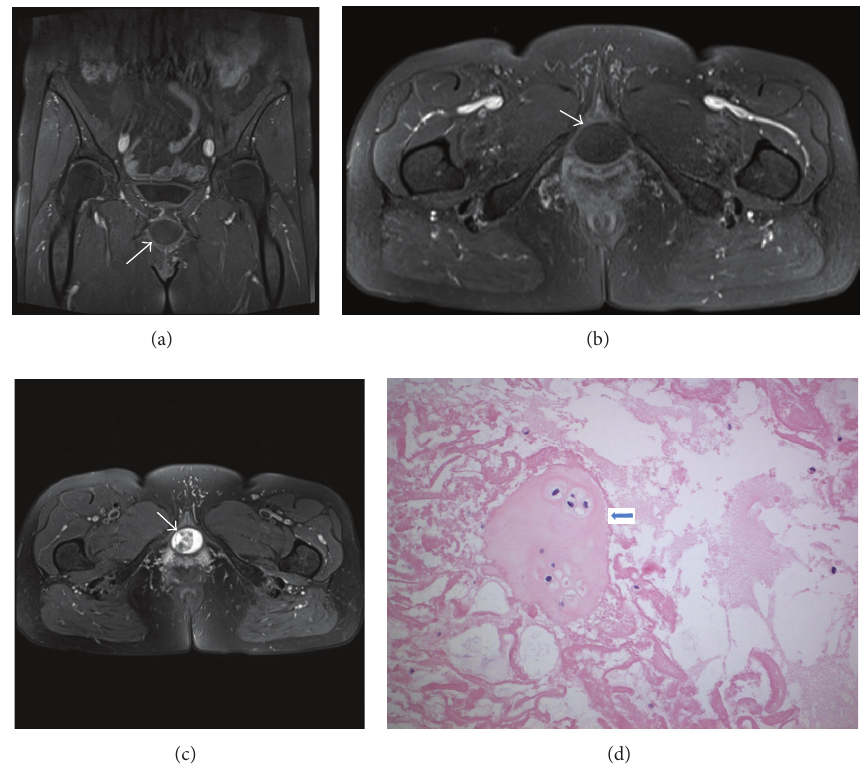
Figure 1: Case 1. A 61-year-old postmenopausal lady presented with voiding dysfunction. Examination revealed painless smooth, rounded, firm, and cystic mass, at the anterior vaginal wall of about 4 cm width related to the pubic symphysis. (a) Coronal T1-weighted image of a rounded, hypointense pseudocyst compared to the muscle tissue. (b) Axial T1-weighted image of the pseudocyst. (c) Axial T2-weighted image depicting a hyperintense, heterogenous pseudocyst. (d) The histopathologic features of the cyst. The 200x image shows an island of hyaline cartilage (arrow) floating in a degenerated fibrinous and mucoid